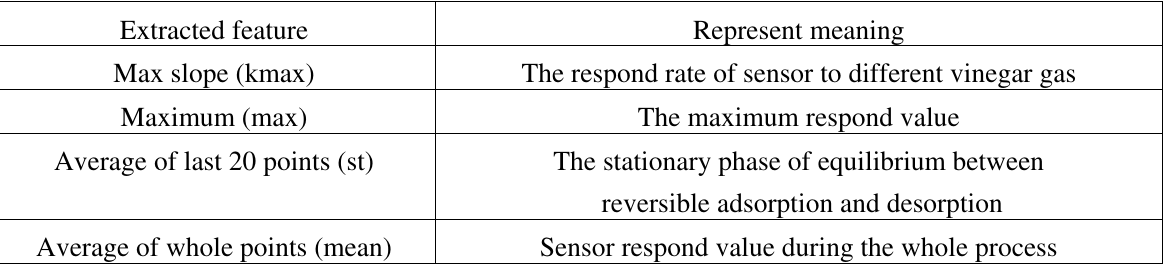
Figure 3. Sensor TGS813 smoothed curve and the features extracted are shown on the curve. Table 1. The represent of the 4 extracted